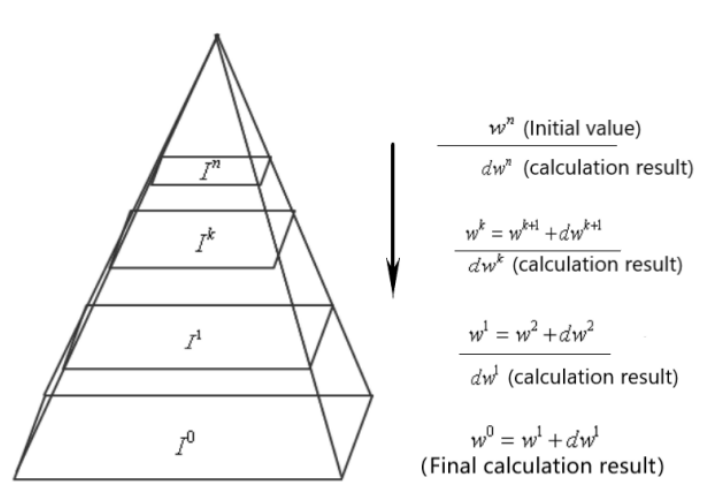
Figure 6. Flow chart of the pyramid optical flow method.